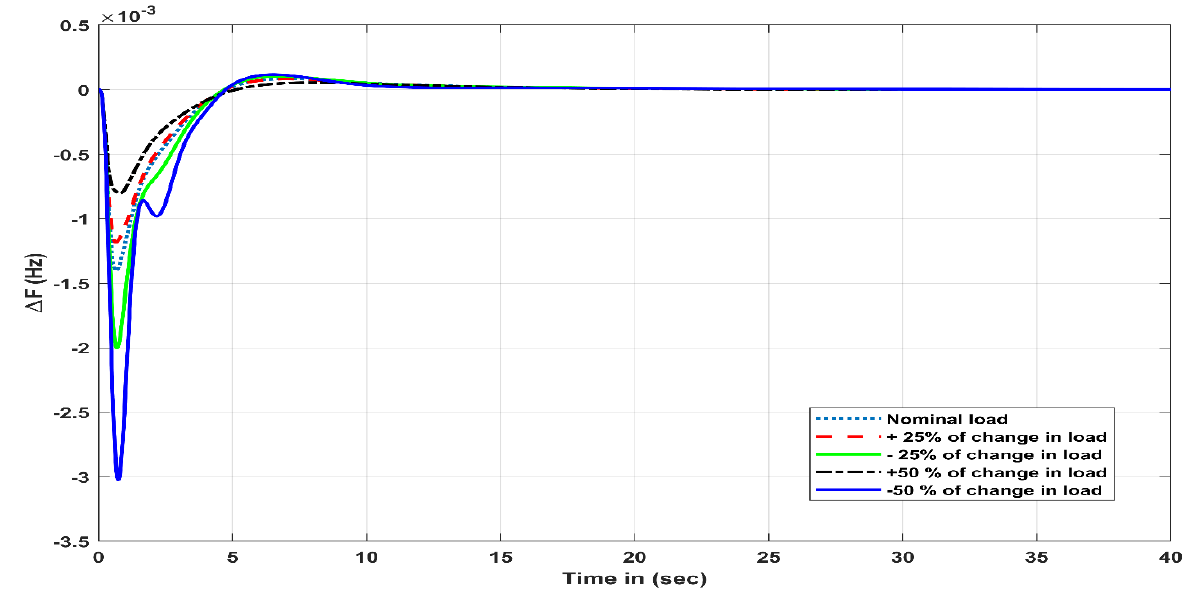
Figure 8. Random load frequency variation of the marine microgrid system.